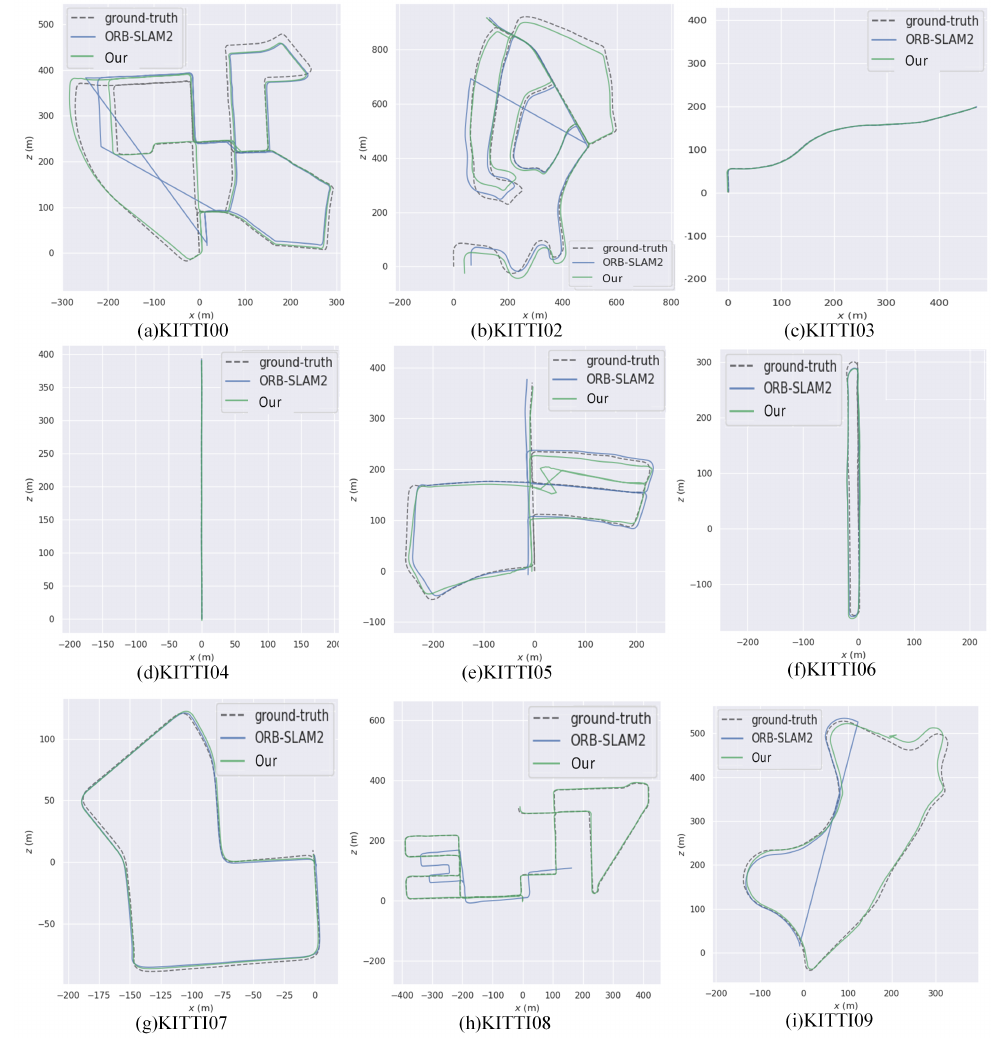
Figure 8. Comparison of trajectories estimated by our SLAM method, ORB-SLAM2, and the ground truth on the KITTI dataset.